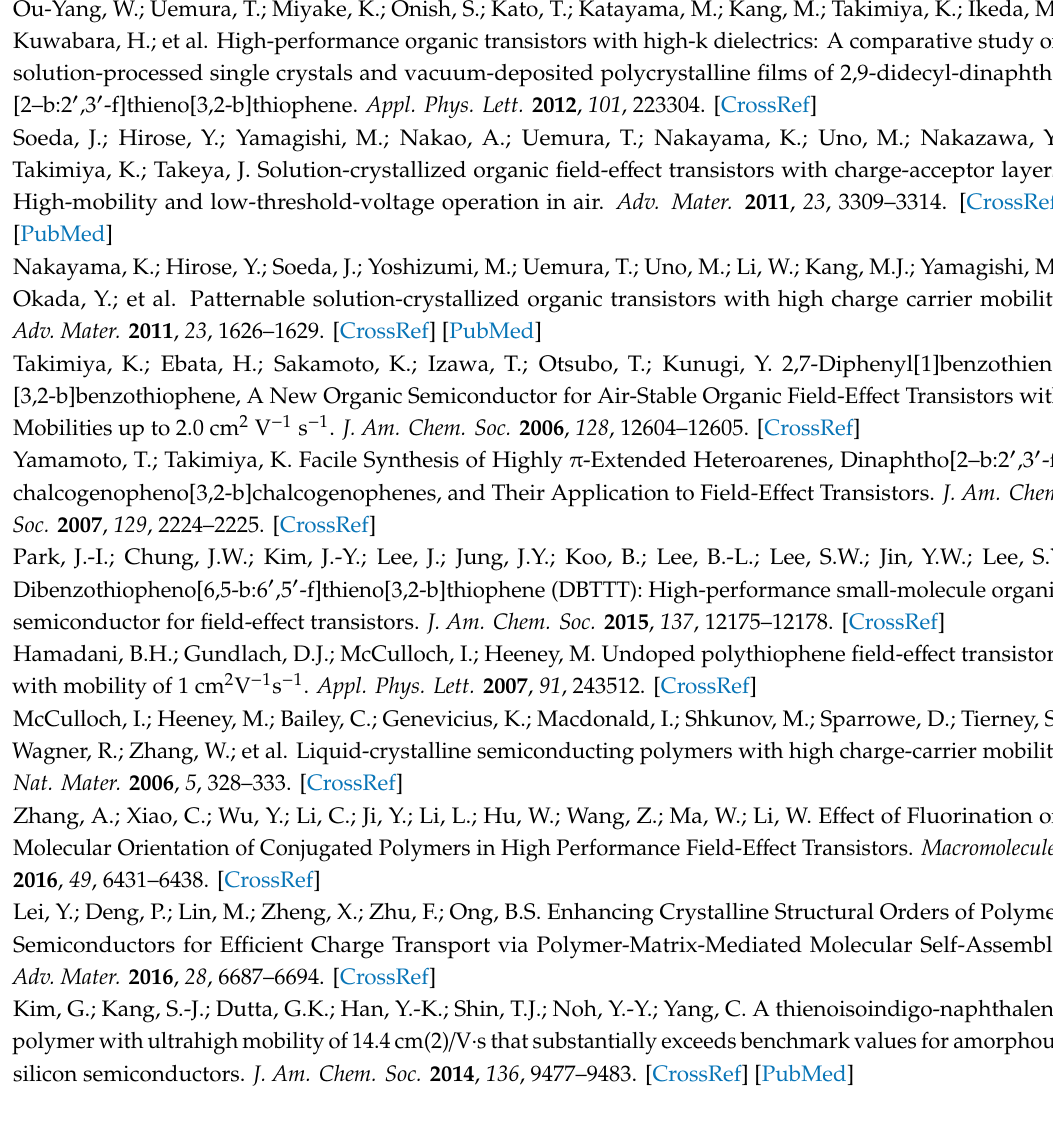
and Figure S3: Solid state variable-temperature 1H MAS NMR and 13C CP / MAS + 13C MAS NMR spectra of CEPVA, Figure S4: Optical microscopy images of TIPS-P layer deposited by dip-coating with various deposition speeds, Figure S5: (a), (b) UV-vis absorption spectra of TIPS-P deposited with various deposition speed with unpolarized and linearly polarized light, respectively, (c) Range of charge carrier mobility in the OFETs with CEPVA50 dielectric and TIPS-P layer deposited at various speed, Figure S6: Wide-angle X-ray scattering profiles of thin films of TIPS-P deposited on four various dielectric